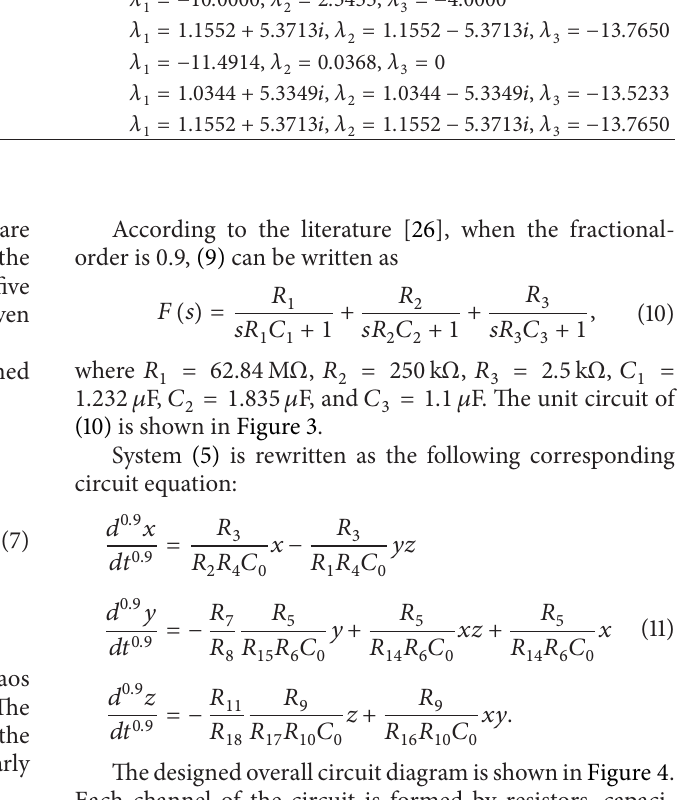
Equilibrium points Their corresponding